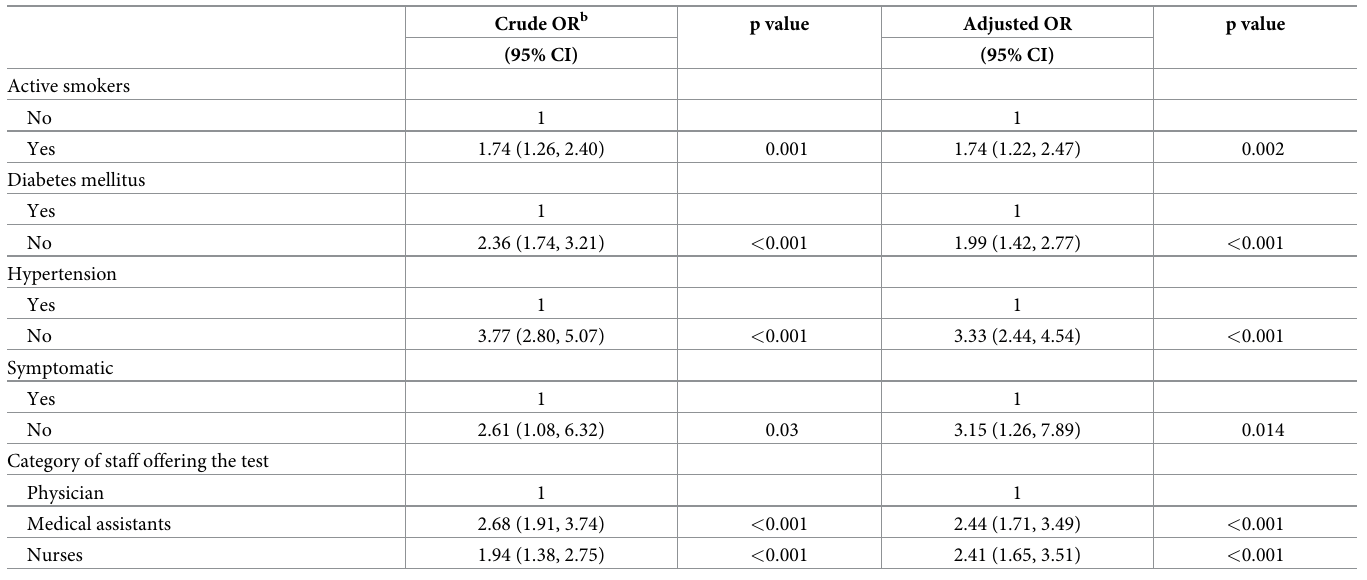
Table 2. Factors associated with the refusal of iFOBT, multiple logistic